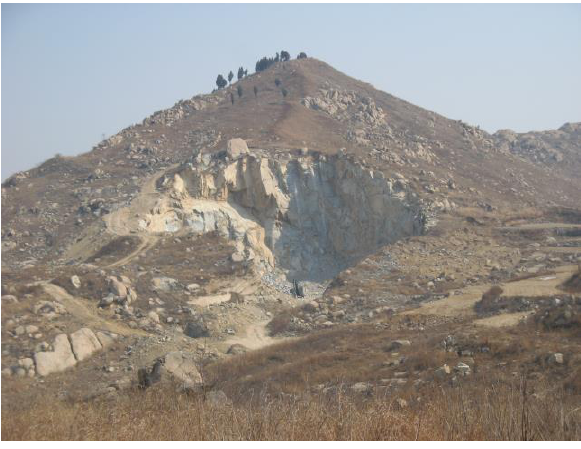
Figure 11. The topographic map of Zhu